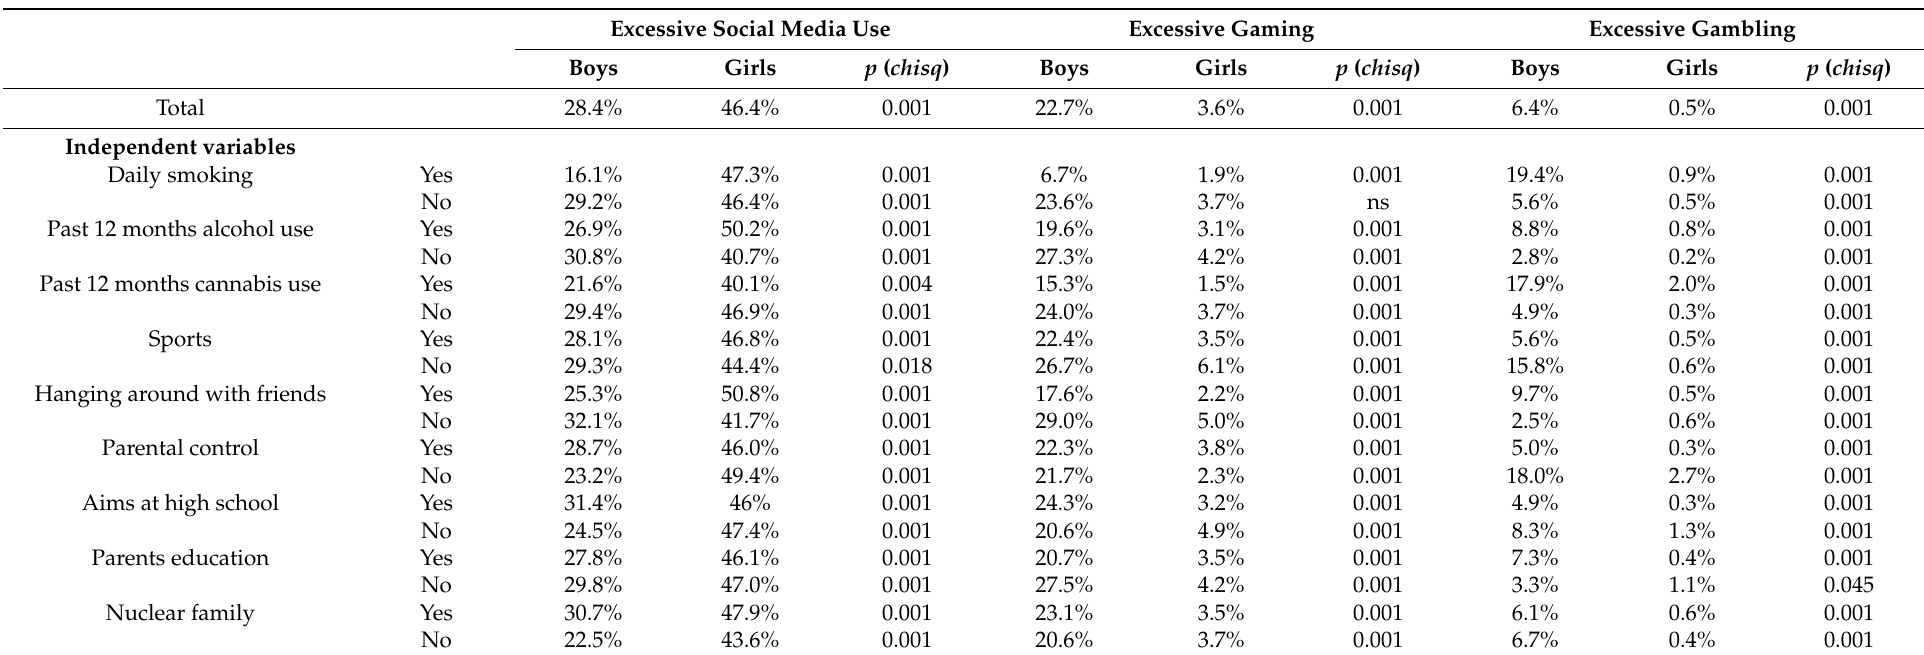
Table 1. Distributions of excessive social media use, excessive gaming, and excessive gambling according to the independent variables among Finnish 15–16 years old boys and girls in 2019 with Rao-Schott’s Chi-square test results on statistical